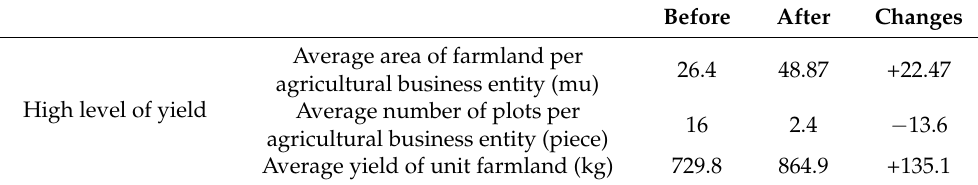
Table 3. Comparison of yield indicators before and after the farmland rights system reform. Before After Changes Average area of farmland per High level of yield